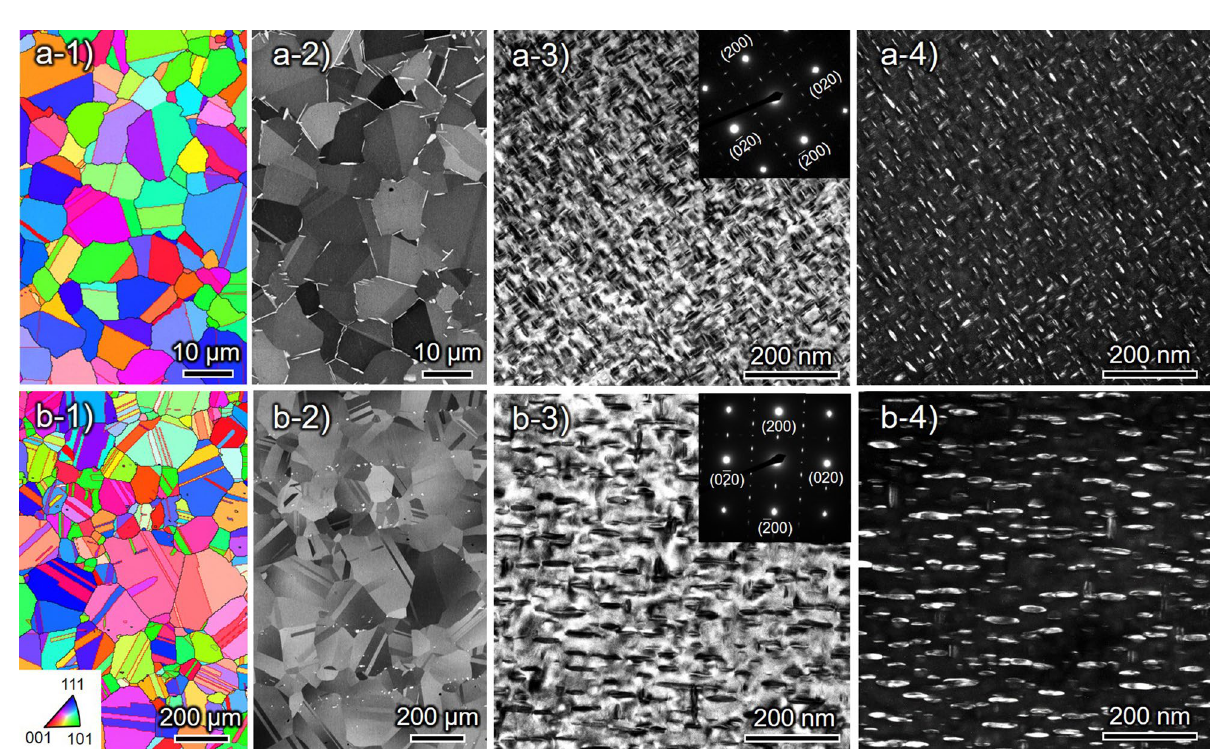
Figure 8. Microstrcutres observed by EBSD, ECC imaging, and TEM for ( a ) δ-FG and ( b ) CG: ( a-1,b-1 ) Inverse pole figure maps with respect to the longitudinal direction; ( a-2,b-2 ) ECC images; ( a-2,b-2 ) Bright-field and ( a-3,b-3 ) dark-field micrographs obtained from [001] zone